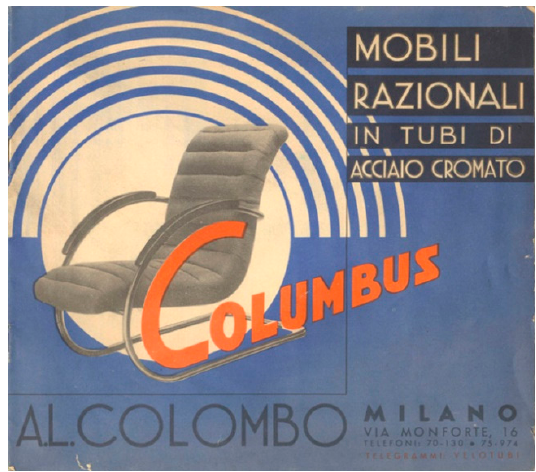
Figure 21. Advertising Columbus company.